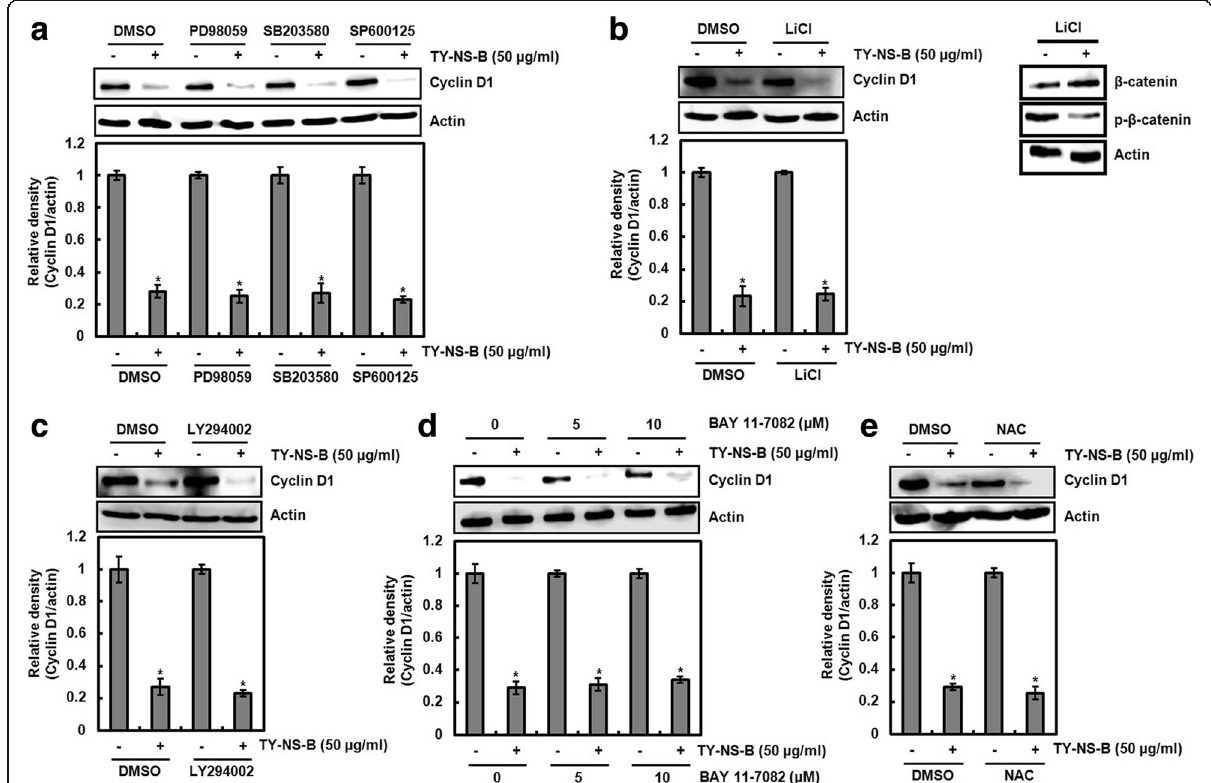
Fig. 7 Determination of factors involved in cyclin D1 degradation by TY-NS-B. a HCT116 cells were pretreated with 20 μ M of PD98059, SB203580 or SP600125. b Right panel: HCT116 cells were pretreated with 20 mM of LiCl. Left panel: HCT116 cells were treated with 20 mM of LiCl ( c ) HCT116 cells were pretreated with 20 μ M of LY294002. d HCT116 cells were pretreated with 5 and10 μ M of BAY 11 – 7082. e HCT116 cells were pretreated with 10 mM of NAC. After pretreatment of each inhibitor, HCT116 cells were co-treated with TY-NS-B (50 μ g/ml). Cell lysates were subjected to SDS-PAGE and the Western blot was performed using antibody against cyclin D1. Actin was used as internal control for Western blot analysis. Relative density for Western blot was measured using the software Un-SCAN-IT gel Version 5.1 (Silk Scientific, Inc). Data represent mean ± SD for three independent experiments. * P < 0.05 compared to cell without